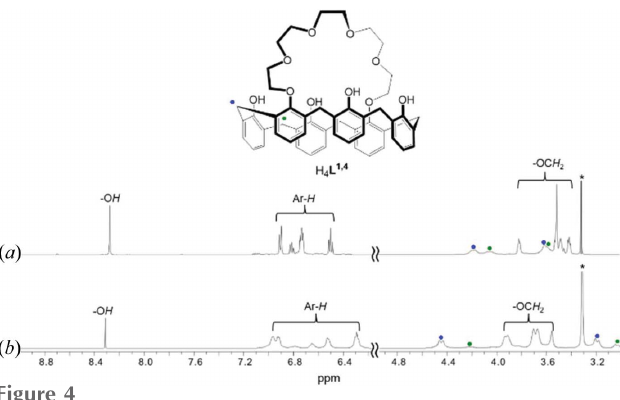
Figure 3 1 H NMR spectra of ( a ) H DMSO- d 6